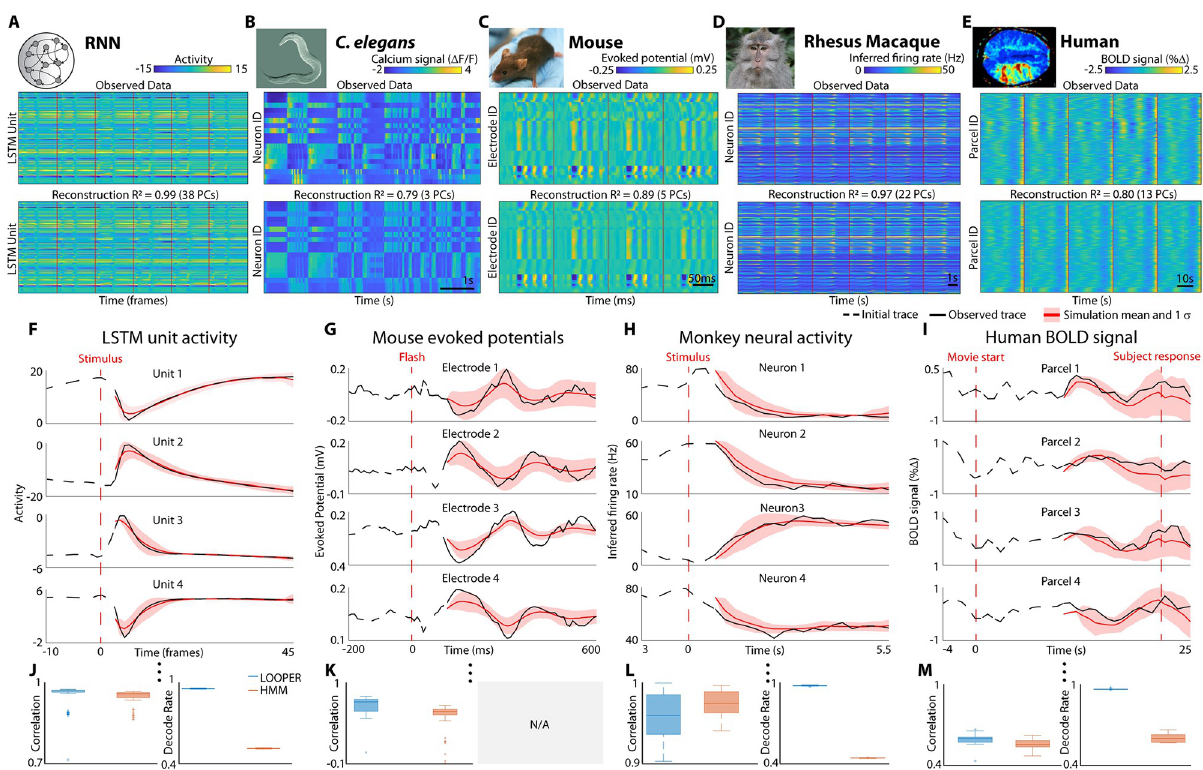
Fig 5. LOOPER model explains majority of variance and predicts future neuronal activity. Simple models obtained using LOOPER are remarkably good at reconstructing the dynamics observed in diverse systems such as artificial recurrent neural networks ( A ), whole brain calcium imaging in C. elegans during spontaneous locomotion ( B ), visually evoked local field potentials in the mouse ( C ), firing of neurons in prefrontal cortex of a primate during working memory task ( D ), and BOLD signals in humans performing a “theory of mind task” ( E ). Top panels in ( A - E ) are experimental observations (red vertical lines show different trials or stimuli timings). Bottom panels are LOOPER reconstruction of the observed activity. R 2 values are calculated between each observed trial (i.e. #channels x time matrix) and the corresponding reconstructed trial. We also include the number of PC components required to achieve an equivalent R 2 in the parentheses. LOOPER models preserve the majority of variance in the data across a vast variety of systems and signal types. LOOPER is also able to predict future neuronal activity of the systems ( F - I ). Black lines are either a single trial (RNN) or a bootstrapped sample of several trials (mouse ! 5 trials; monkey ! 10 pseudo trials (see main text); BOLD signals ! 60 trials). Top four panels show examples of four recording channels (total of 100 LSTM units, 49 electrodes in mouse, 179 neurons in monkey and 264 parcels in human). Red lines show an average of 100 simulations of the LOOPER model (shaded area shows standard deviation). The bottom panels show the distribution of correlation coefficients computed across multiple bootstrap subsets (or individual trials) and recording channels. For each experimental system, the LOOPER model is constructed on a subset of trials. Validation trials (or bootstrapped averages) are constructed from a non-overlapping subset of trials. Each simulation begins at the same timepoint in the trial (beginning of solid black line). The initial conditions for the LOOPER simulation are given by the closest model bin to the observed neuronal activity at this time. The dynamics starting from these initial conditions given by the LOOPER model are simulated and projected back into observation space for comparison to experimental observations. Note that the simulation periods are chosen such that no task-relevant stimuli are present, and so no input is required for the simulations. Correlation is computed over the period of the simulation starting from t 0 and continuing for several time steps (RNN ! 40 time steps, mouse ! 50 time steps, monkey ! 19 time steps, human ! 20 time steps). Median correlation values are RNN ! 0.98, mouse ! 0.79, monkey ! 0.95, human ! 0.62, ( J - M ,blue box, left). We also compared LOOPER’s simulations to simulations using conventional HMMs using the same methodolgy as above ( J - M , orange box, left). Finally, we used both the LOOPER and HMM models to attempt to decode the state of the system at each point in time and task condition. The task decoding rate is the average difference between the model’s decoding rate and the expected decoding rate given the task (Romo task: 50% during the interstimulus period and 100% after the presentation of F2, Theory of Mind task: 100% during the period of separation in Fig 4B). Average decoding rates are shown in Fig 5J–5M (blue and orange boxes, right). Chance level decoding rate given a uniform distribution null model of the Romo task is 25%, and for the Theory of Mind task it is 50%. Note that the mouse data has no associated task and so is left blank.